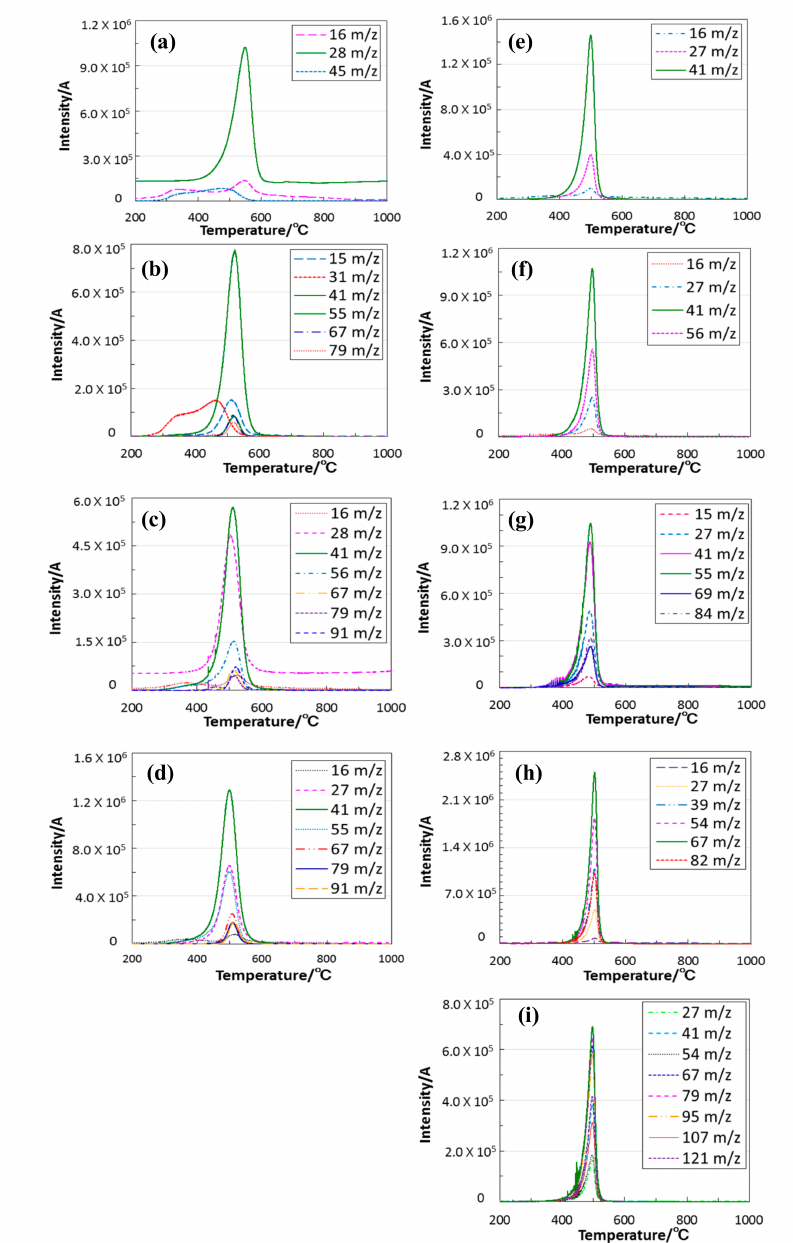
Figure 6. Continuous in-situ monitoring of the evolved gaseous species by mass spectroscopy. ROSZ sample polymers with R = ( a ) Et [22]; ( b ) nPr; ( c ) nBu; ( d ) nHex; ( e ) iPr; ( f ) sBu; ( g ) sHex; ( h ) Cy and ( i )